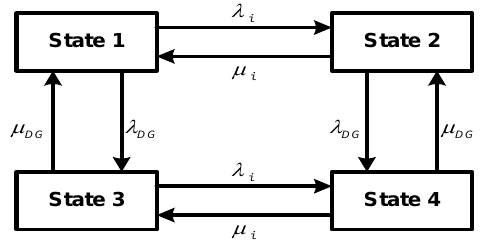
Figure 2. A four state representation for typical distribution system with one DG